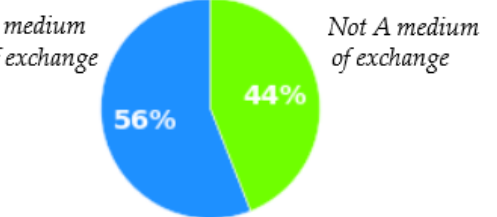
Figure 11. Answers for question of what functions of currency do you think that cryptocurrencies have?